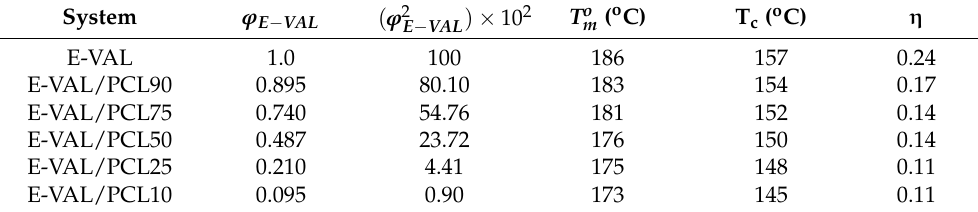
Table 3. Parameters of the Hoffman–Weeks plot for E-VAL in the E-VAL/PCL